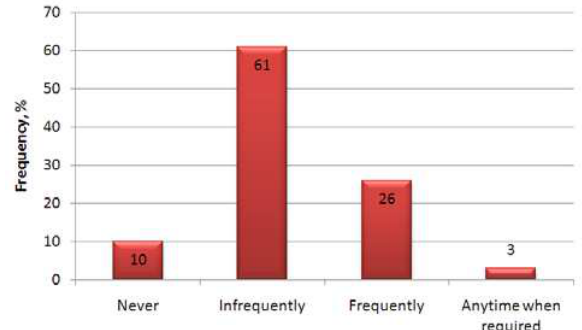
Fig. 13. Frequency of receiving agricultural extension services